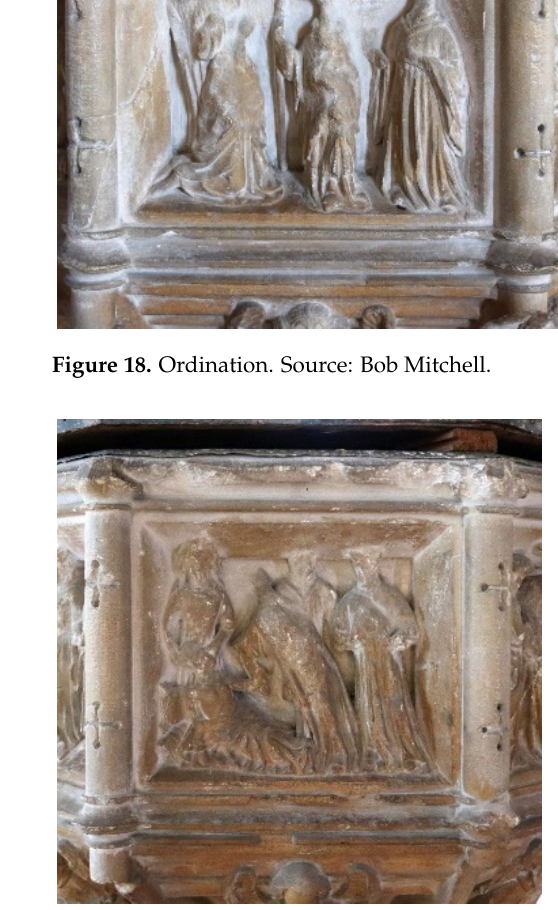
Figure 19. Extreme Unction. Source: Bob Mitchell.